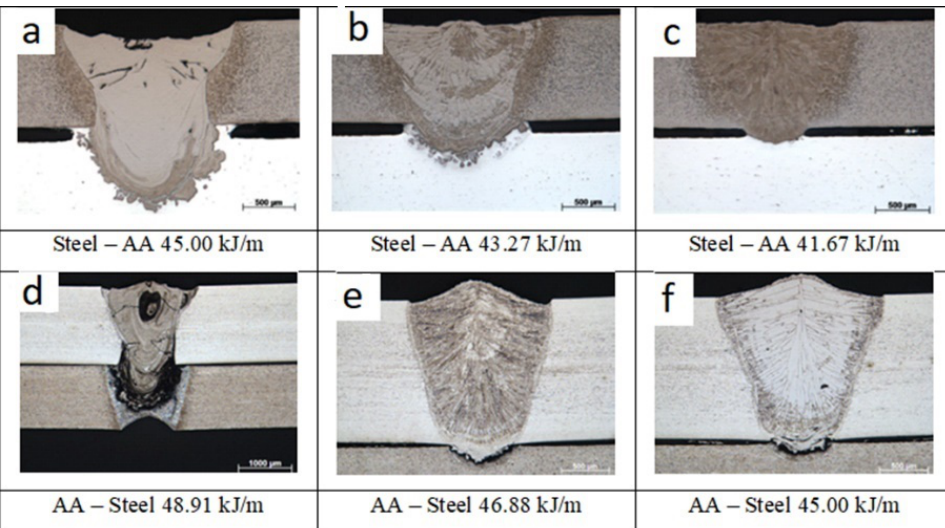
Figure 6. Microstructure of welded joints, ( a – c )–impact of the beam from the steel side, ( d – f )–impact of the beam from the aluminum side [2].